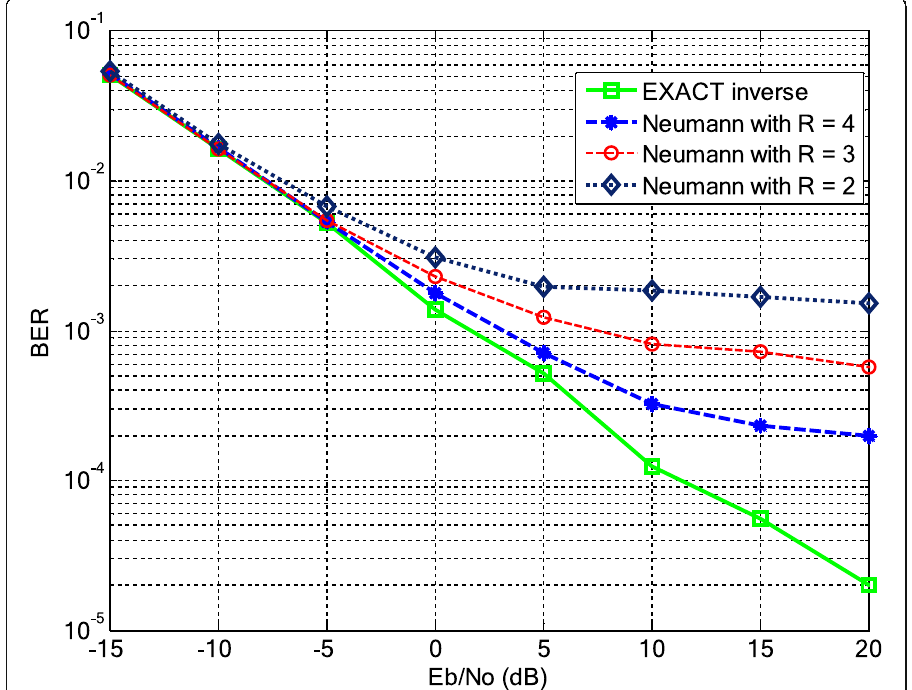
Fig. 2 BER performance of the system by utilizing Neumann seriesBER performance is evaluated by changing the order of the Neumann series, i.e., R = 2, 3, 4. The BS is equipped with N = 320 antennas